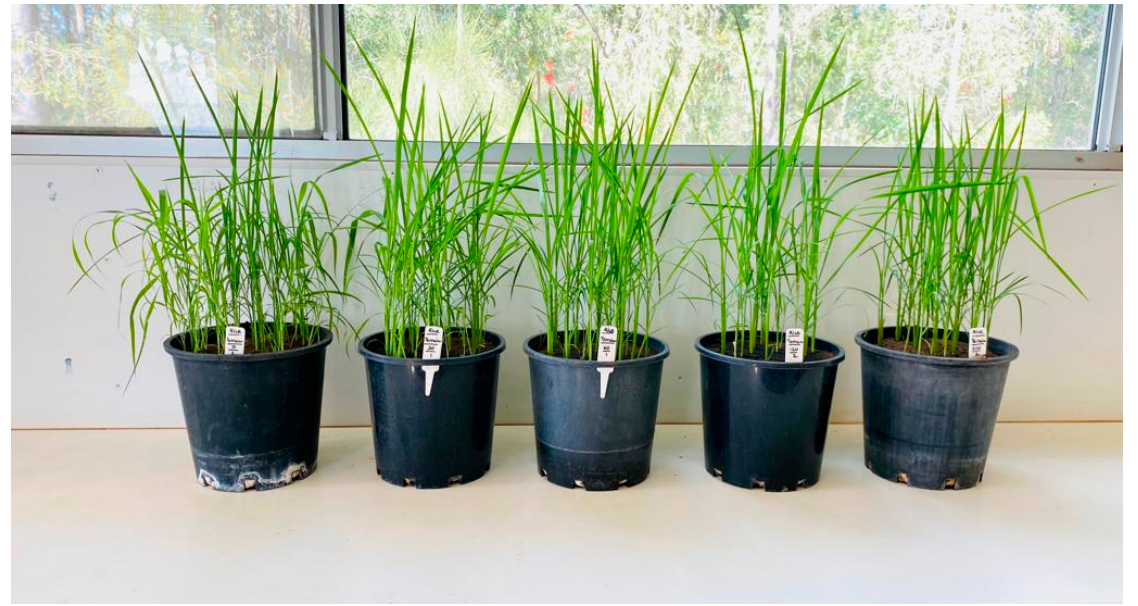
Figure 1. Rice seedlings in response to flumioxazin doses (Left to Right: Flumioxazin doses are in increasing order: 0, 15, 30, 60, and 120 g ai ha − 1 .